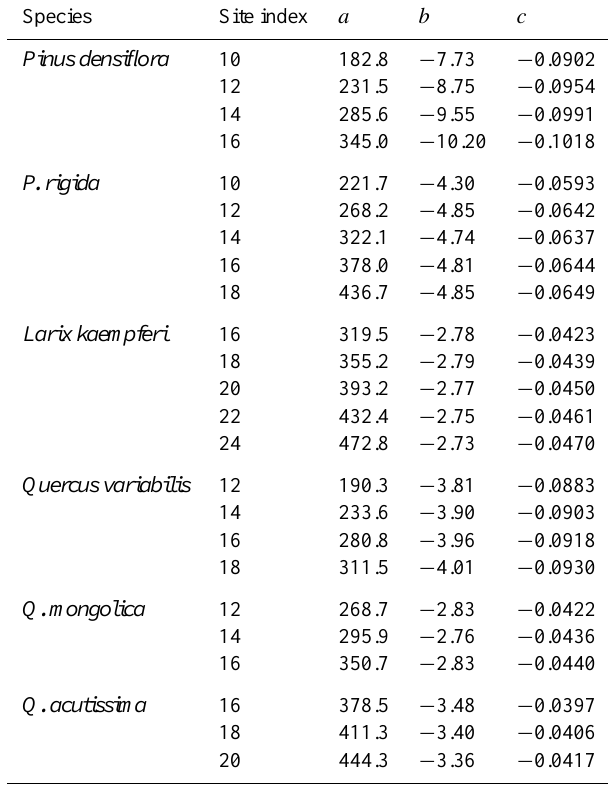
Table A1. Parameter estimates of the Gompertz function for stem volume (m 3 ha − 1 ) for six dominant species by site index in Korea. Volume ( age ) = a · exp (b · exp (c · age ))